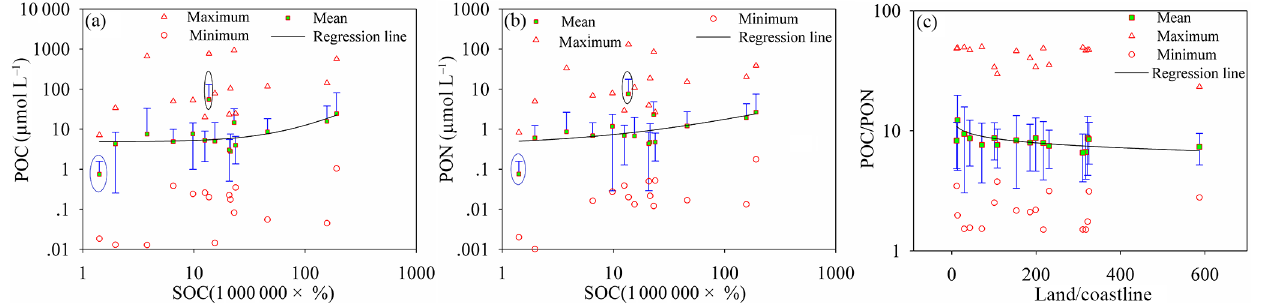
Figure 9. (a, b) Relationship between POC, PON and soil organic carbon. (c) The relationship between POC / PON and the ratio of land area to coastal linear length. The red boxes with green shading are the mean values of POC, PON and POC / PON in each latitudinal range, the blue line is the standard deviation, and the red triangles and circles are the maximum and minimum values of POC, PON and POC / PON in each latitudinal range.